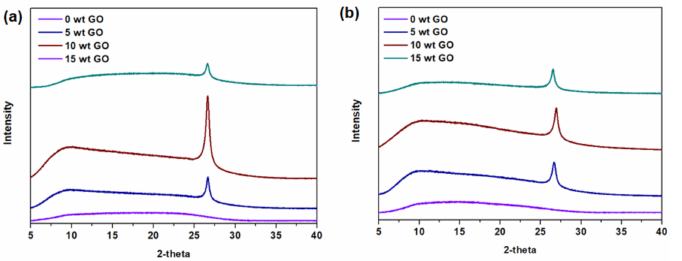
Figure 6. X-ray diffraction patterns of mixed-matrix CMSMs derived from ( a ) Matrimid ® 5218 and ( b ) ODPA-TMPDA membranes with systematic increase in GO